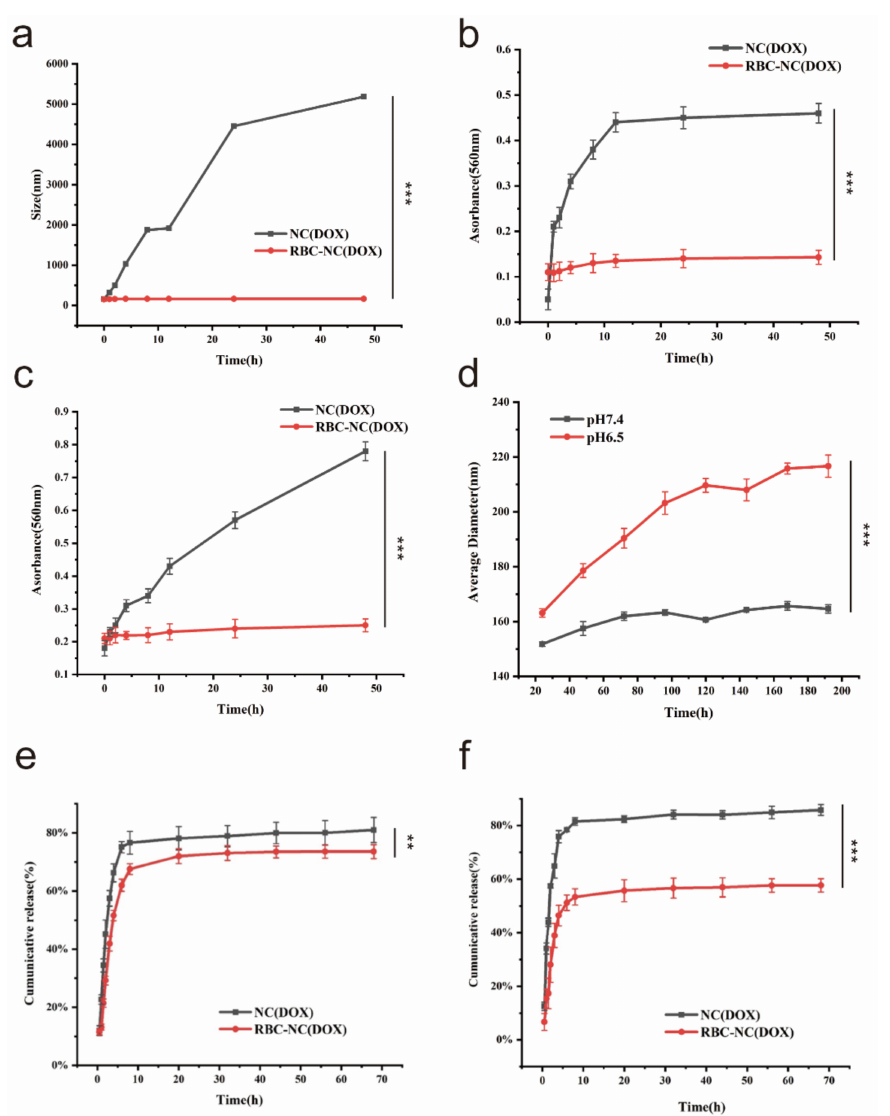
Figure 3. ( a ) Long-term stability study of NC(DOX) and RBC-NC(DOX) in 2 days. ( b ) The absorbance of NC(DOX) and RBC-NC(DOX) at 560 nm in PBS and ( c ) 10% FBS. ( d ) The size change of RBC- NC(DOX) in different environments. ( e , f ) Cumulative release profile of DOX from NC(DOX) and RBC-NC(DOX). ( e ) pH 6.5, ( f ) pH 7.4. Error bars represent standard deviations (n = 3). ** and *** indicate p < 0.01 and p < 0.001,